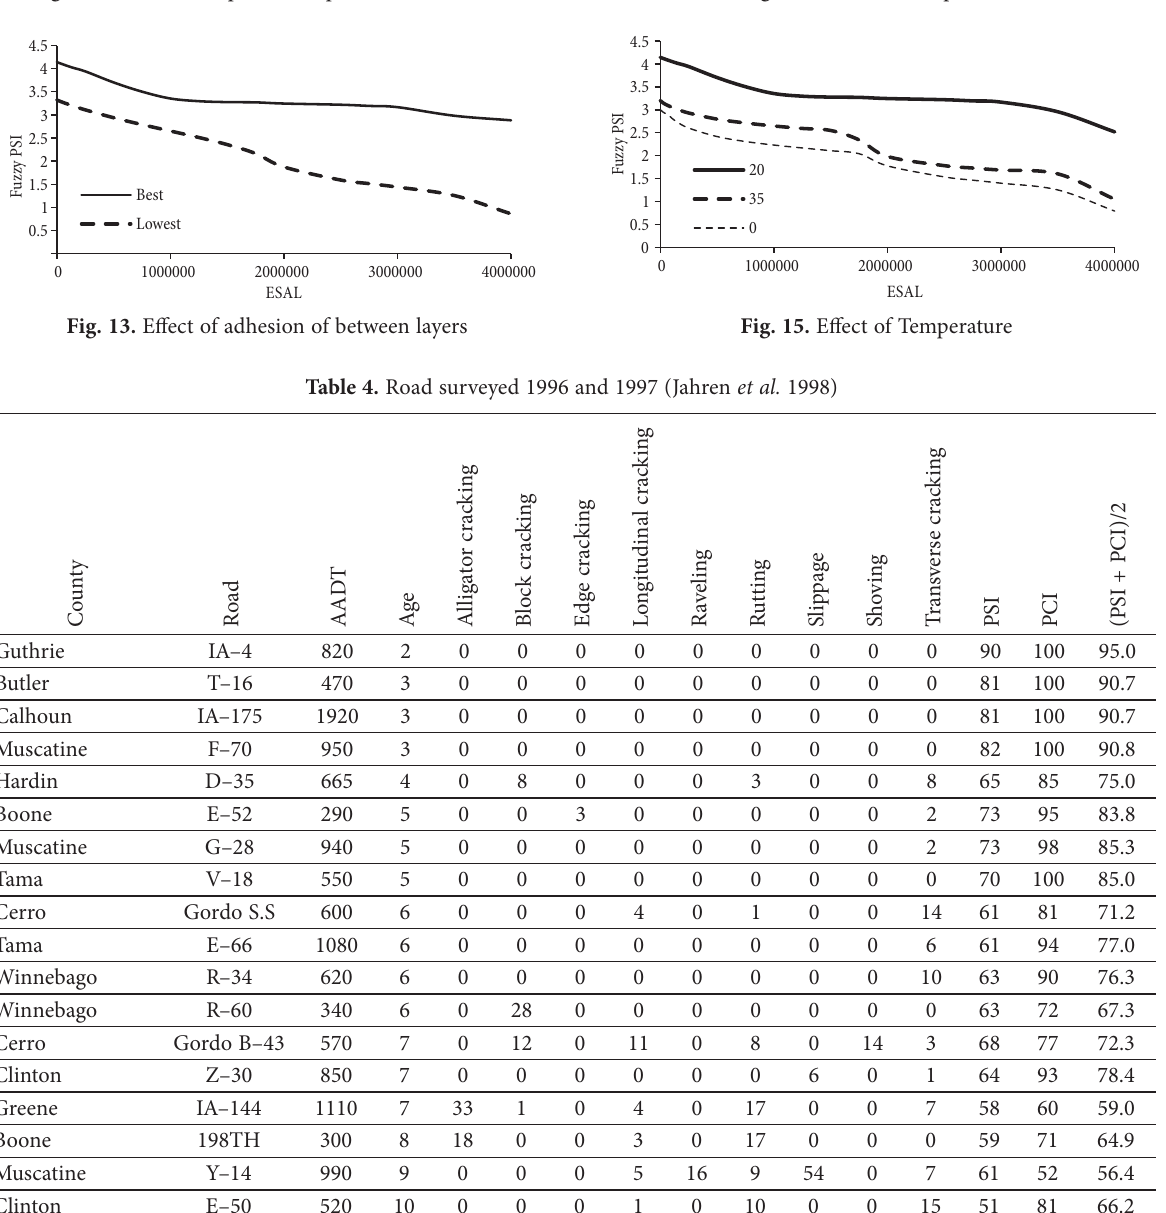
Fig. 14. Effect of Compaction